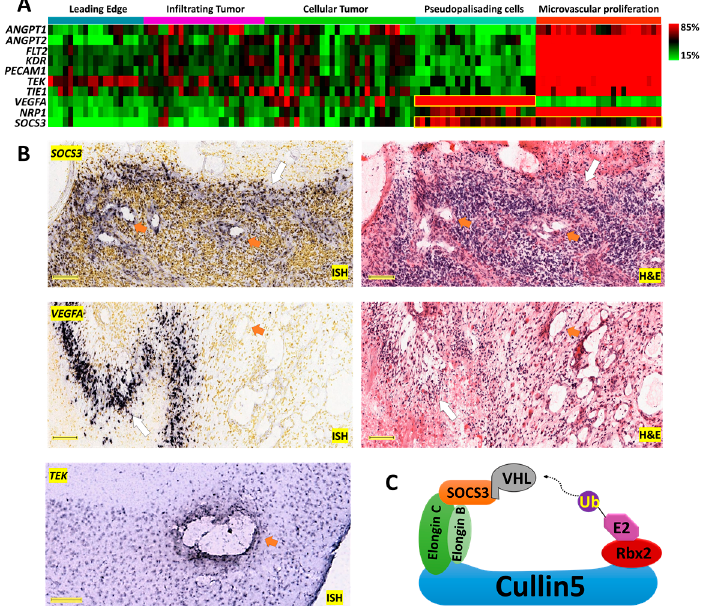
Figure 1. Anatomical mapping of SOCS3 and angiogenic genes in glioblastoma (GBM) clinical samples. ( A ) Expression levels of angiogenesis markers ANGPT1 , ANGPT2 , FLT1 , PECAM1 , TEK , TIE1 , VEGFA , NRP1 , and KDR are mapped on corresponding anatomical structures. The yellow squares highlight the anatomical expression patterns of VEGFA and SOCS3 . ( B ) In situ hybridization (ISH) and hematoxylin and eosin (H&E) analysis of SOCS3 and VEGFA in GBM patients, Scale bar: 200 µ M. ISH analysis of TEK in normal murine cranial tissue. Scale bar: 150 µ M. Image credit: Ivy- GAP, Allen Institute. Orange arrows indicate blood vessels. White arrows indicate pseudopalisading cells around necrosis. ( C ) Schematic overview of the CRL5 E3 ligase. SOCS3 in the CRL5 can recruit von Hippel–Lindau (VHL) for polyubiquitination and degradation.